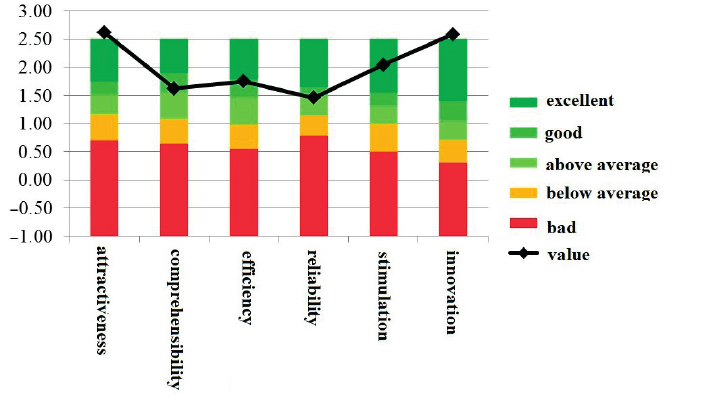
Figure 2. Quiver Application evaluation results comparison with user experience questionnaire standard (source: created by the